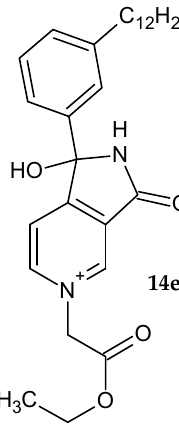
Figure 10. 1 ‐ Phenyl ‐ pyrrolo[3,4 ‐ c ]pyridine ‐ 3 ‐ one derivatives 14a ‐ e as InhA enzyme inhibitors. Figure 10. 1-Phenyl-pyrrolo[3,4- c ]pyridine-3-one derivatives 14a – e as InhA enzyme